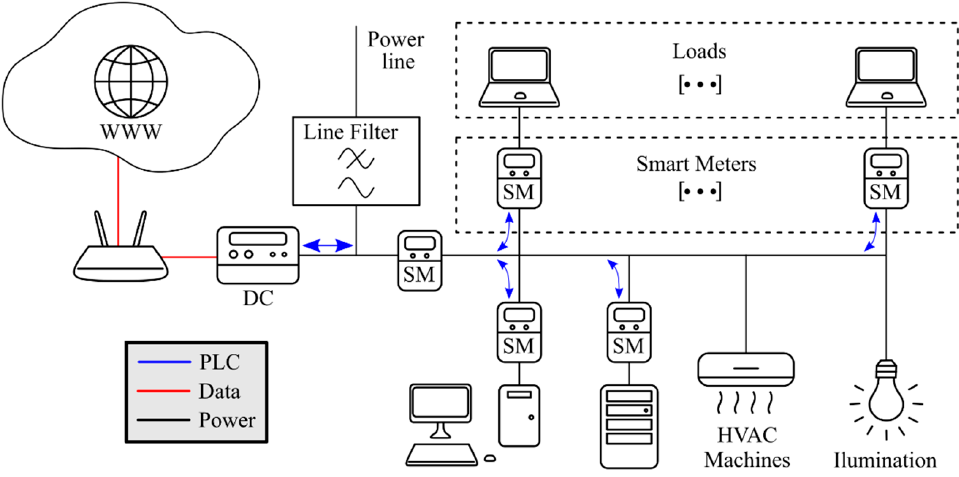
Figure 8. Smart metering